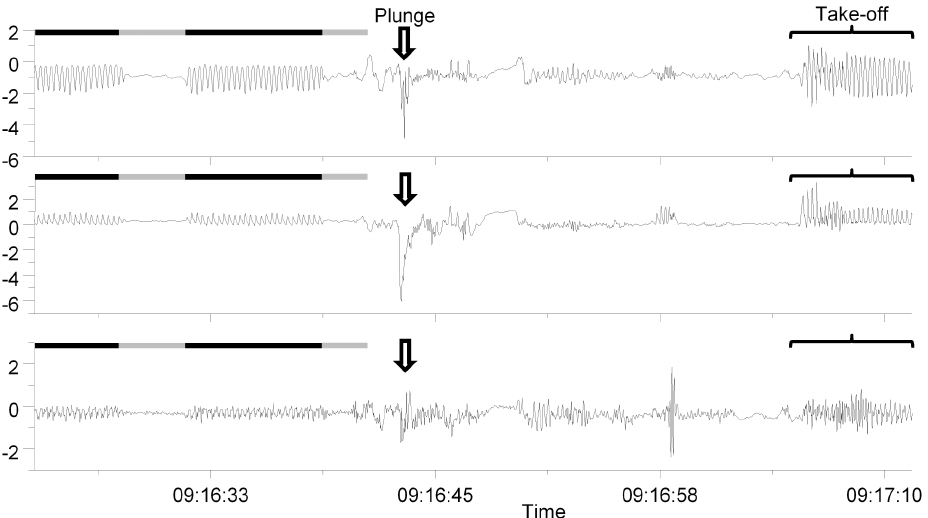
Figure 2. Tri-acceleration signal showing the behaviour of a gannet during a foraging trip. Example of gannet behaviour recorded by a data-logger (X6-2mini accelerometers, GCDC LLC, Waveland, US) showing the tri-axial acceleration signature during flight (flapping – black horizontal bars and gliding - grey bar) just before and after a plunge dive (indicated by the arrow followed by phase on sea surface before flapping to take-off). doi:10.1371/journal.pone.0092657.g002 PLOS ONE |